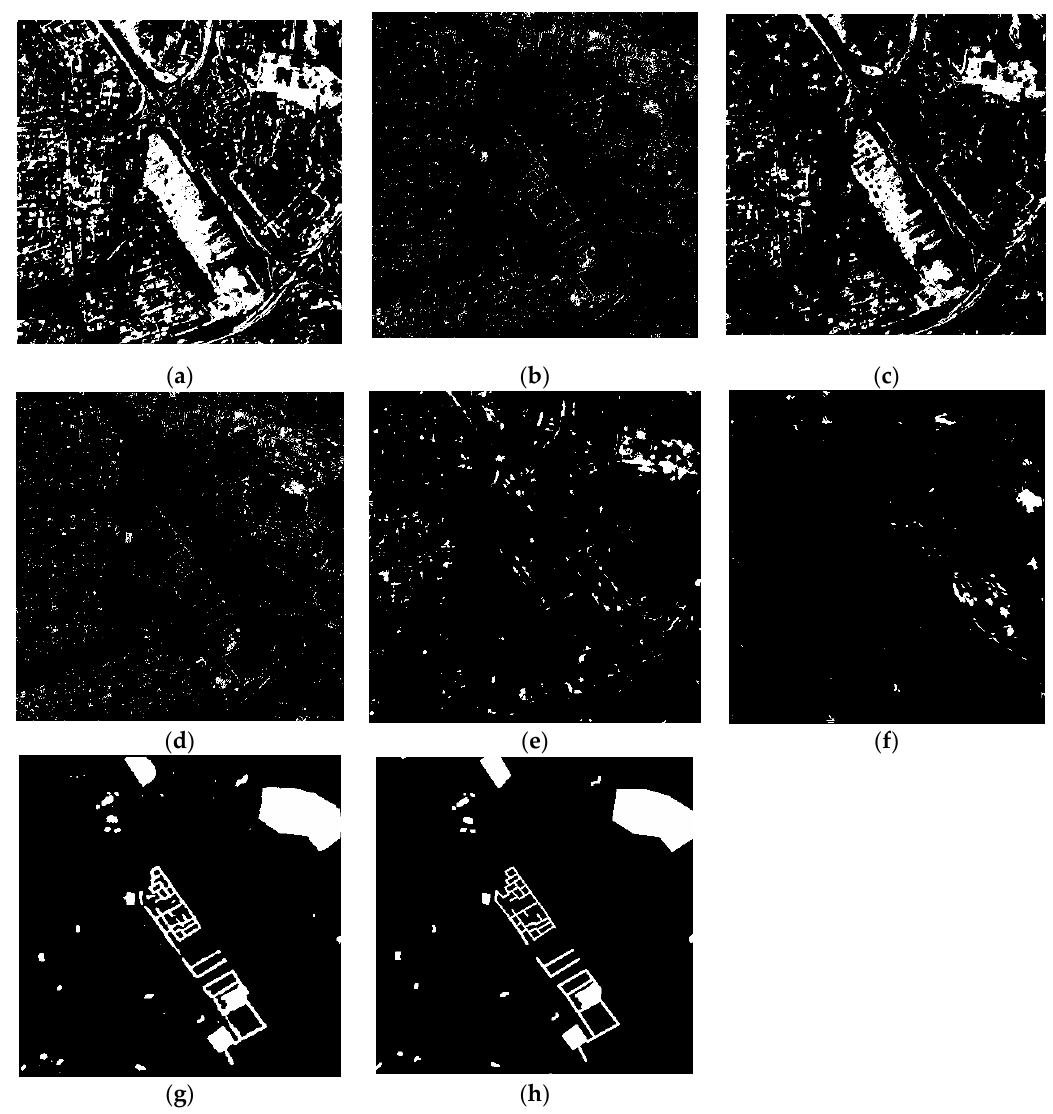
Figure 9. The change detection maps produced by different CD methods for the Multispectral-Abudhabi dataset. (a) CVA-SVM, (b) MAD-SVM, (c) PCA-SVM, (d) IR-MAD -SVM, (e) SFA-SVM, (f) 3D-CNN, (g) Proposed Method, and (h) Ground Truth. White and black colors indicate the change and no-change areas, respectively.